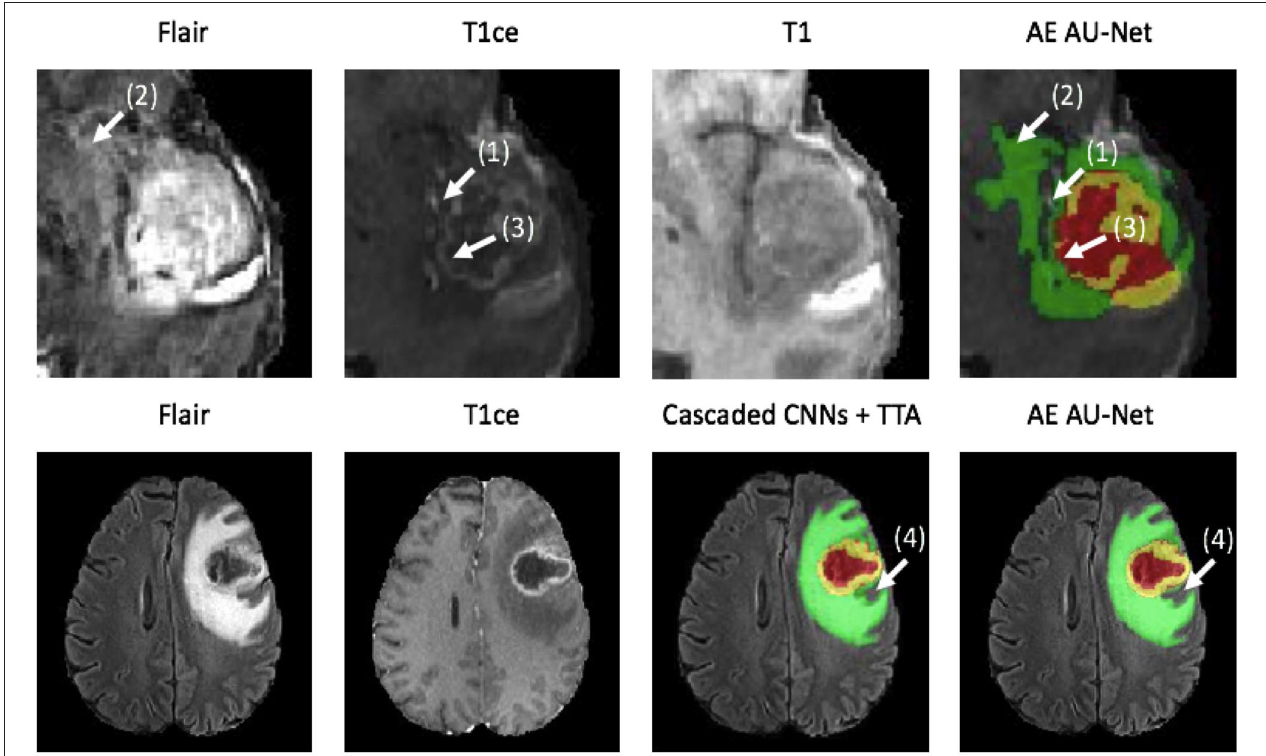
FIGURE 5 | Qualitative results. Two example segmentations using our proposed ensemble. In the top patient identified as CBICA_ZA_1 and in the bottom the patient CBICA_ALZ_1, both from the BraTS 2018 validation dataset. In the bottom, we compare our results with the segmentation made using the Cascaded Networks + TTA presented in (51).